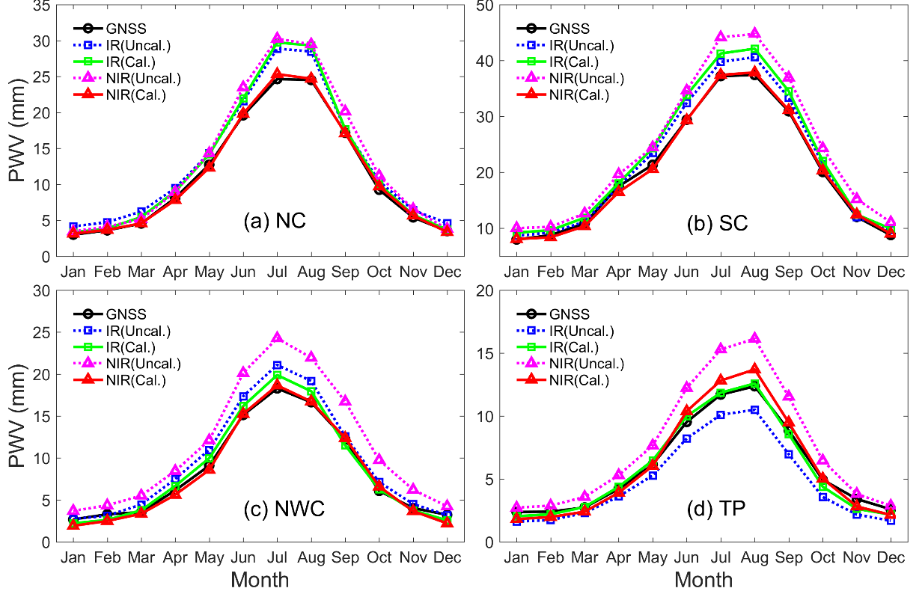
Figure 13. Seasonal variation of PWV derived from MODIS IR/NIR and GNSS PWV over the period of 2011 – 2017 in the four areas in China, where ( a – d ) are NC, SC, NWC and TP of China. In addition to the seasonal variation of PWV, the long-term MODIS-derived PWV can also be used for the trend analysis of atmospheric water vapor. The annual, semi-annual, and seasonal periods, as well as the trend component in GNSS PWV time series, can be estimation of PWV trend and different periods over Mainland China. Prior to the modeling of MODIS-derived PWV time series, the preprocess of PWV time series is performed using the interquartile range (IQR) method [53] to remove the outlying PWV values. The